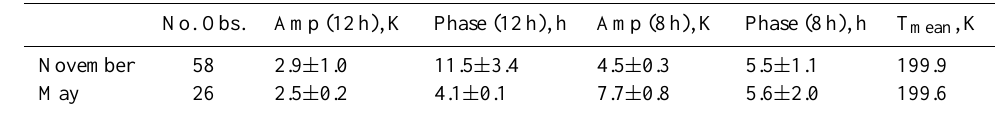
Table 2b. WINDII temperature tidal-fit parameters at 28 ◦ S and at 89km height.